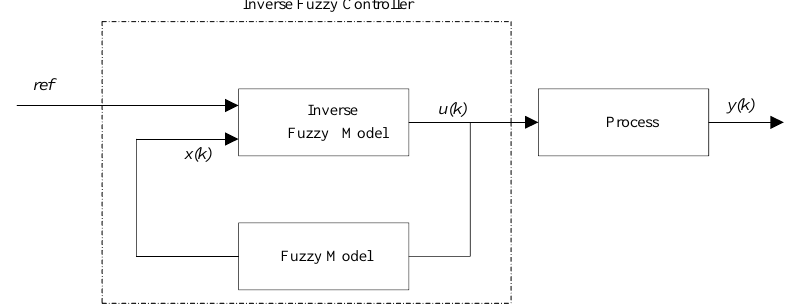
Figure 7. Open loop structure of the IT2-FM inverse controller.